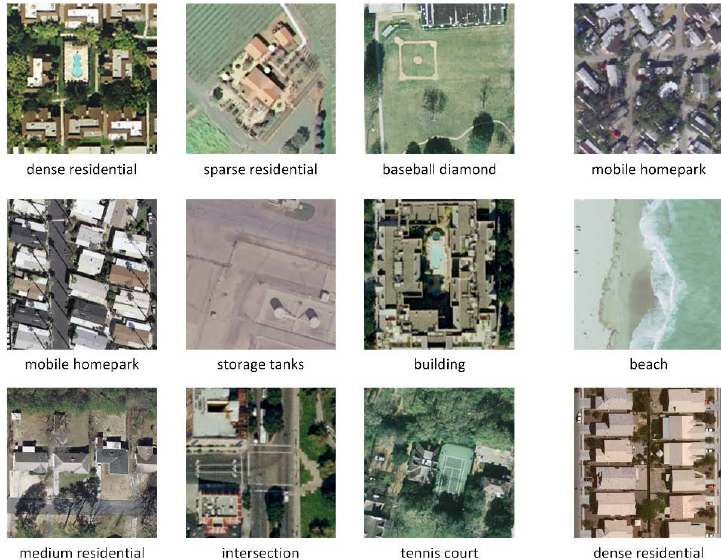
Figure 12. Several example images that compare results from CCP-net and SPP-net on the UC Merced dataset. Images, where SPP-net failed, are shown in the first three columns and images where CCP-net failed are shown in the last column.